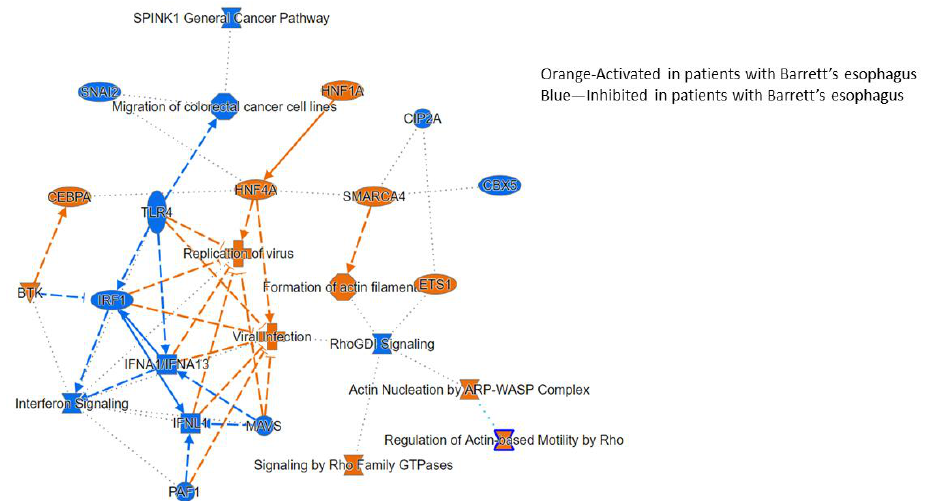
Figure 6. Ingenuity pathway analysis of processes related to Barrett’s transcriptome.